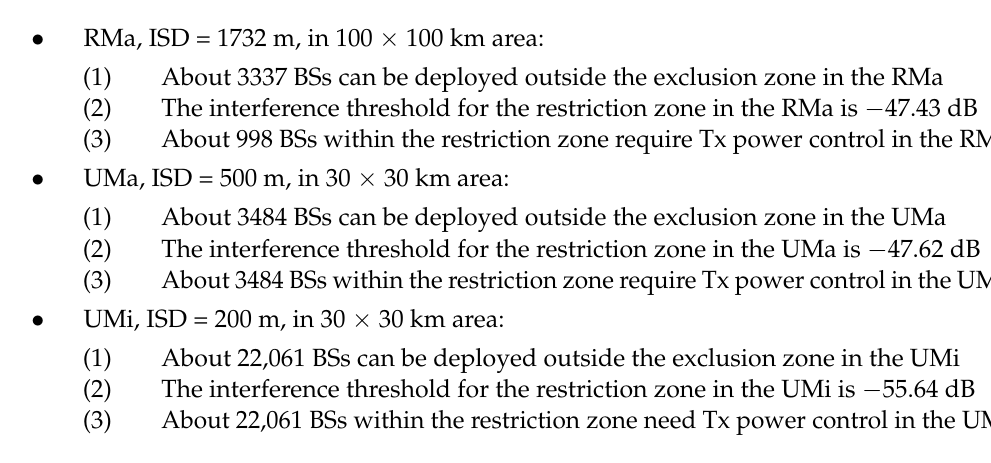
Figure 23. Mean Tx power reduction for the BS versus the number of BSs.